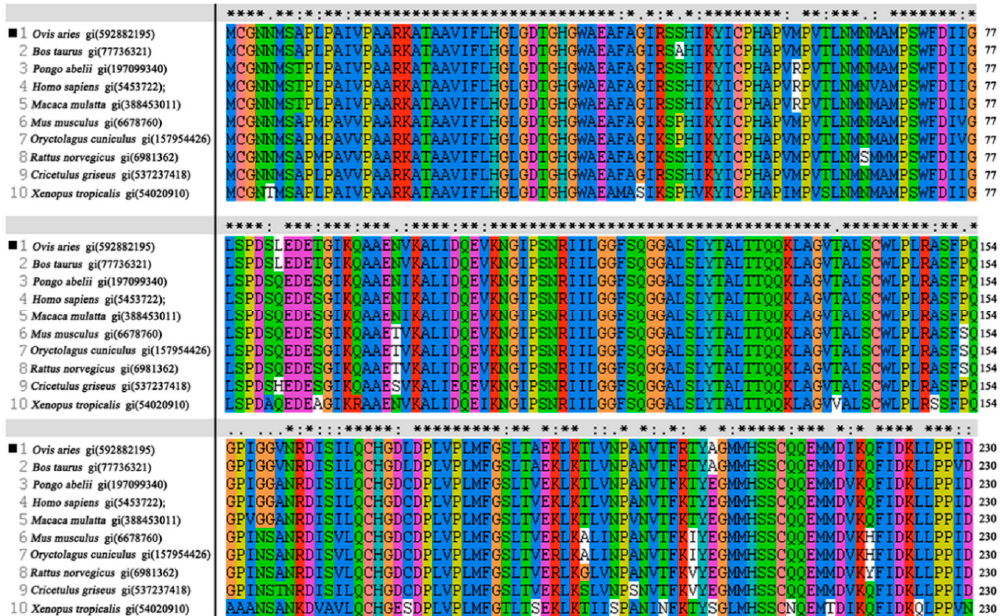
Figure 2. Multiple alignment analysis of the amino acid sequences of LYPLA1s from different vertebrates. The conserved amino acid residues of LYPLA1s are indicated by asterisks (*) above the column. Conserved substitutions are shown by colons (:), and dots (.) indicate semi-conserved